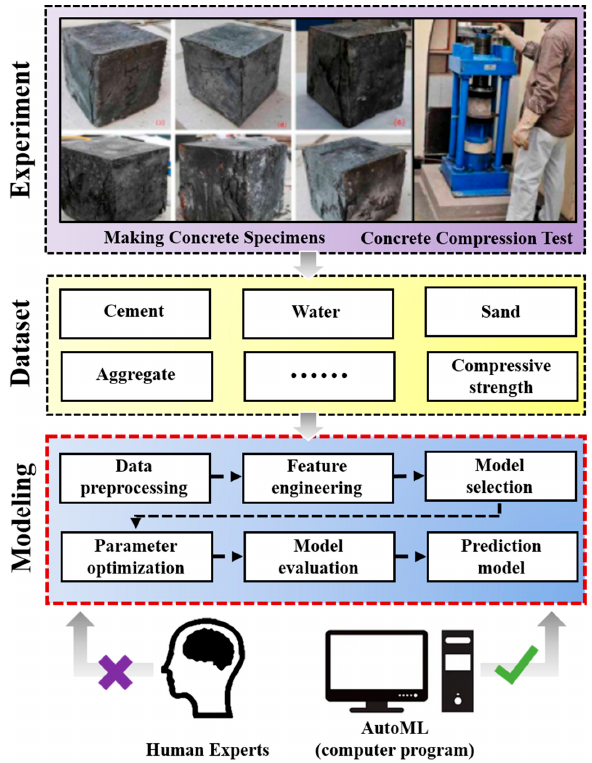
Figure 5. Differences between ML and AutoML for concrete compressive strength